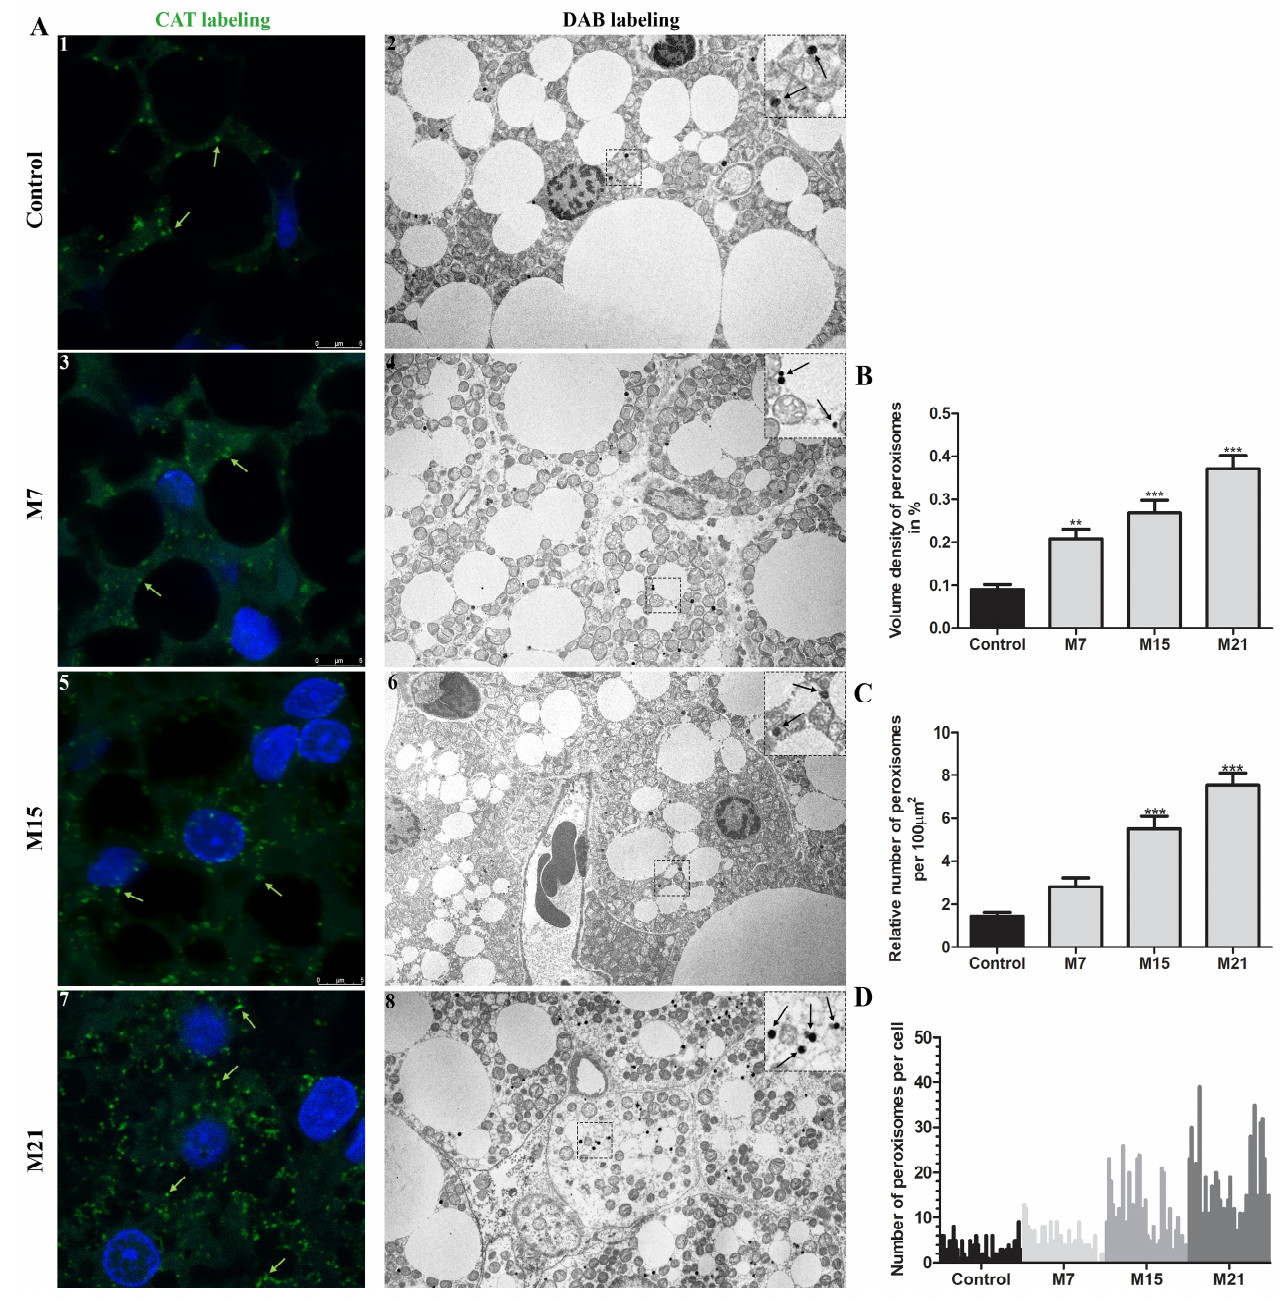
Figure 1. Hypothyroidism-induced peroxisomal proliferation in brown adipocytes. ( A ) Immunofluorescent (1,3,5,7), and DAB labelling (2,4,6,8) of peroxisomes (arrows) in brown adipocytes in euthyroid (Control; 1–2) and hypothyroid groups treated with methimazole for 7 (M7;3,4), 15 (M15;5,6), and 21 (M21;7,8) days, respectively. Immunofluorescent labelling of CAT (green, arrows) showed an increased presence of peroxisomes during the treatment. DAB labelling (black, arrows) indicated their number and distribution per cell in more detail. ( B ) The volume density of peroxisomes per group is presented as a percentage. ( C ) Relative number of peroxisomes per group, standardized to 100 µ m 2 of cell area, and ( D ) distribution of their number per cell within the group. Scale bars: Confocal microscopy 5 µ m, electron microscopy 1 µ m. Bars represent the mean ± SEM. * Compared to control, ** p < 0.01, *** p < 0.001.